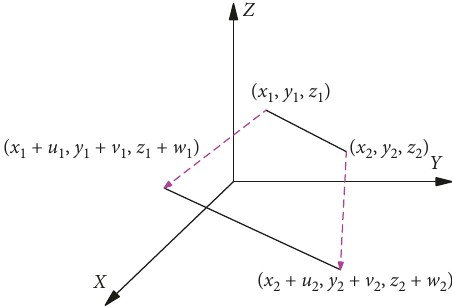
Figure 10: Nondeformed and deformed geometry of a truss